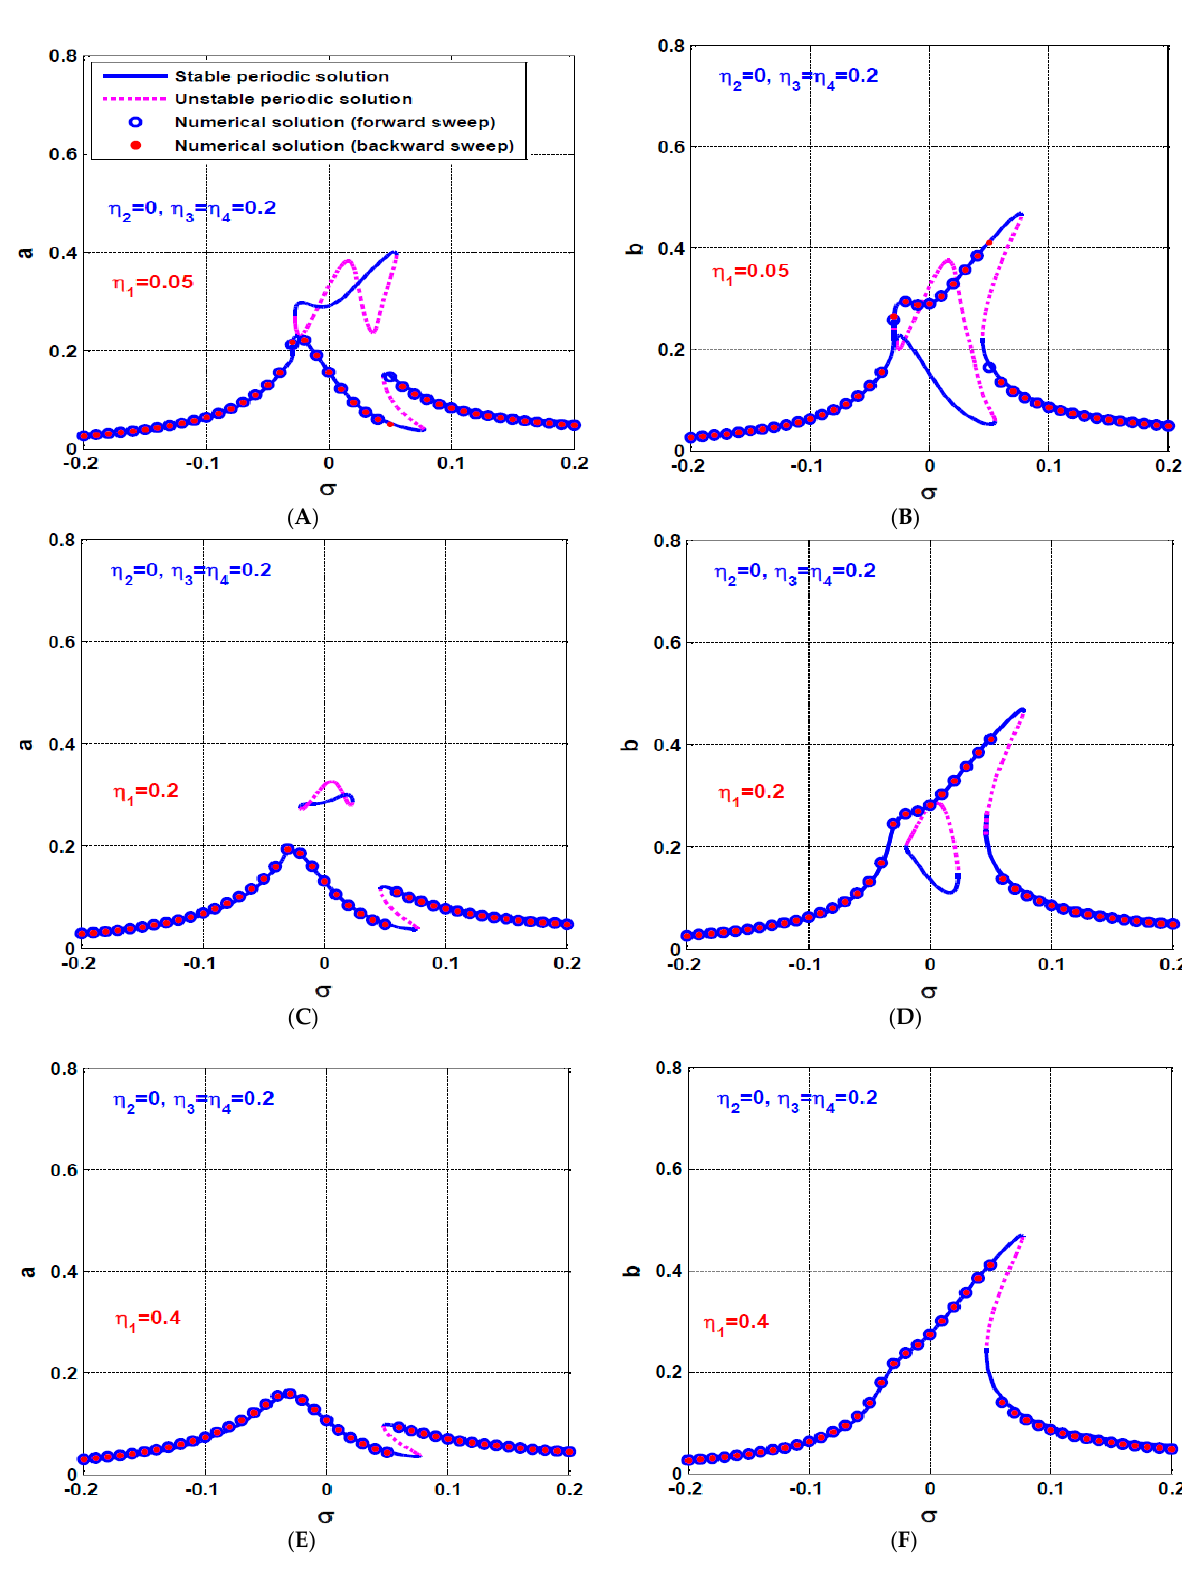
Figure 5. The rotor system σ response curve at three different values of the control signal gain η 1 when η 2 = 0, η 3 = η 4 = 0.2 and f = 0.015: ( A , B ) the system oscillation amplitudes a and b when η 1 = 0.05, ( C , D ) the system oscillation amplitudes a and b when η 1 = 0.2, and ( E , F ) the system oscillation amplitudes a and b when η 1 =